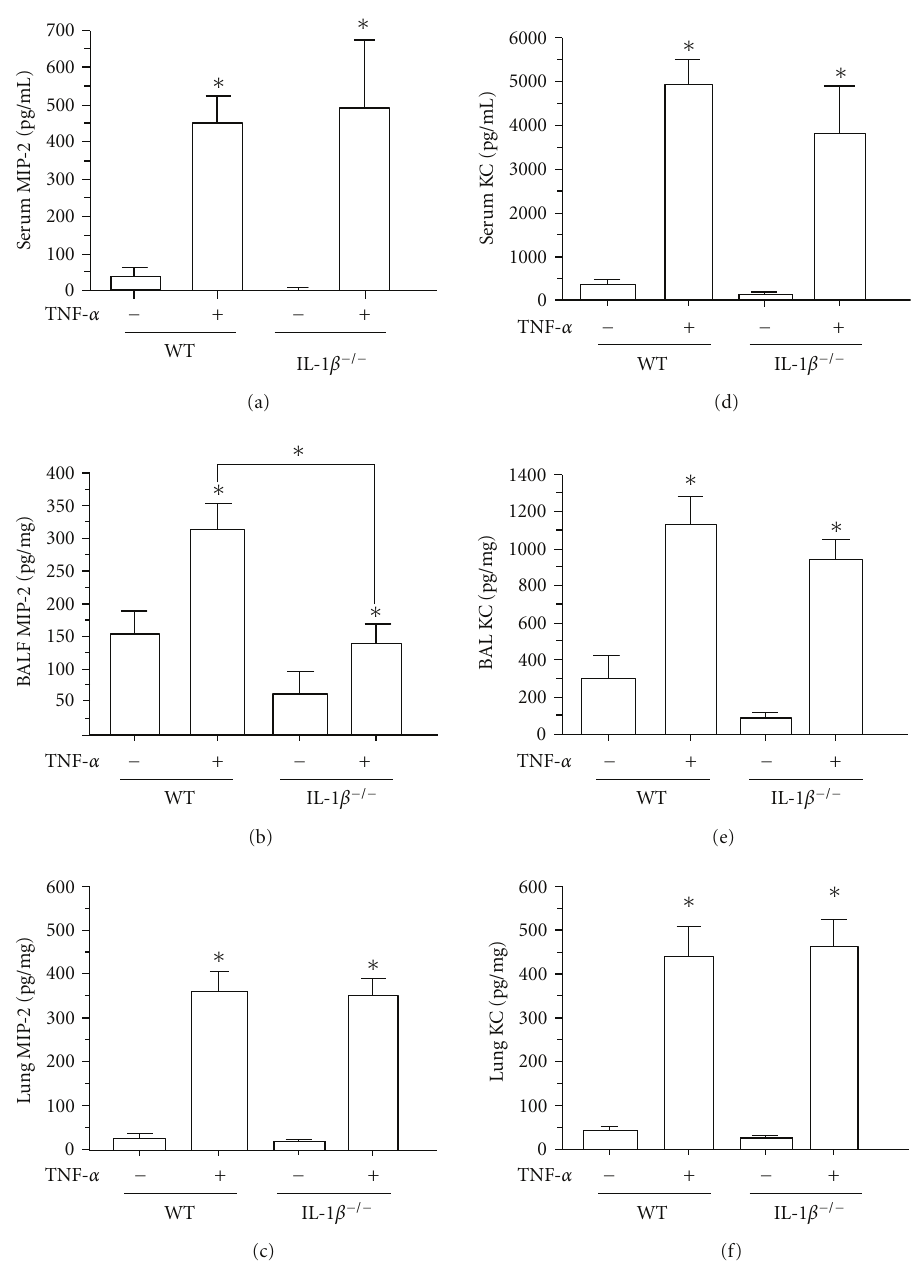
Figure 3: Analysis of MIP-2 after TNF- α instillation . WT or IL-1 β KO mice were OP instilled with either saline (50 μ L) or TNF- α (5 μ g/50 μ L/mouse). After 6 hours, serum, BALF, and lung homogenate were isolated and analyzed for ((a), (b), and (c)) MIP-2 and ((d), (e), and (f)) by ELISA. BALF and lung homogenate values are normalized to protein content measured by BCA. Results are mean ± SEM, ( n = 8–15). ∗ represents P ≤ . 05 saline versus TNF- α -treatment of single strain or (brackets) for saline or cytokine-treated comparisons between